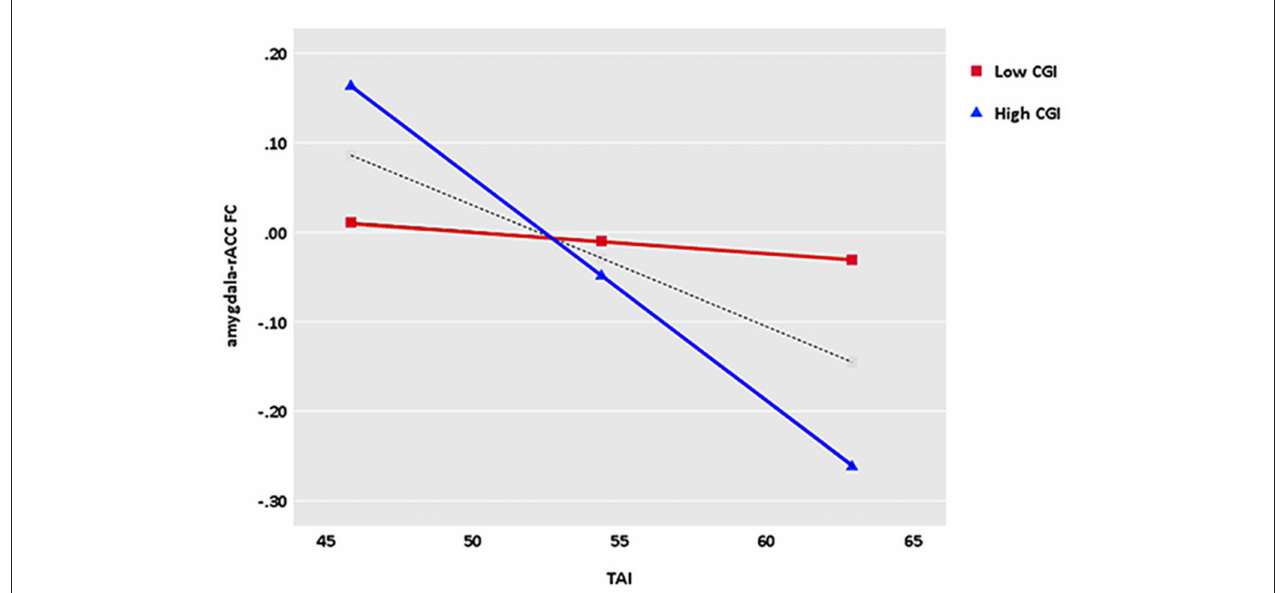
FIGURE 4 | The CGI-S scores moderate the relationship between trait anxiety and amygdala–rACC